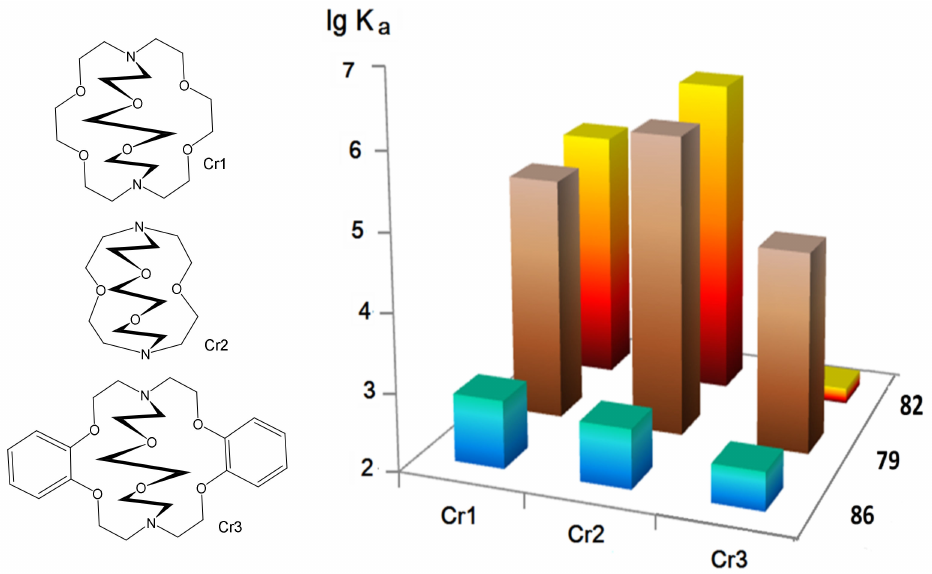
Figure 26. Stability constants of the complexes of receptors 79 , 82 and 86 with Cr1-Cr3